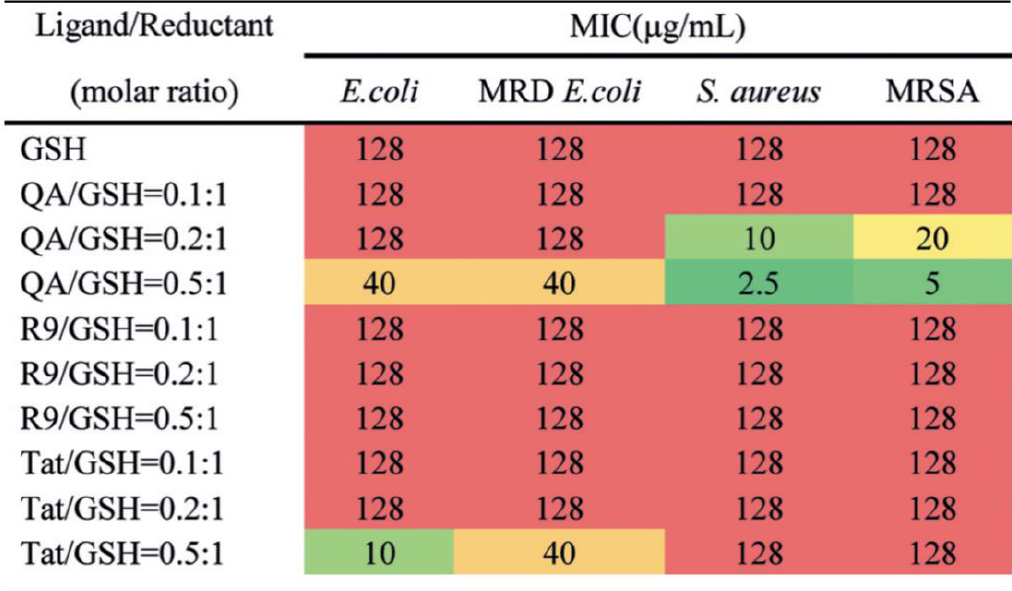
Figure 4. Antibacterial activities of AuNCs conjugated with different ligands by measuring their MICs. The lower MIC of AuNCs show higher antibacterial activity. Reproduced with permission from Reference [75]. Copyright © 2018, WILEY-VCH Verlag GmbH & Co. KGaA, Weinheim.